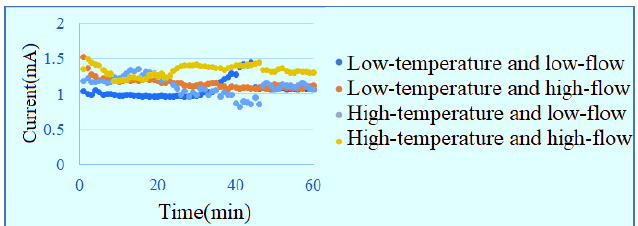
Figure 12. Current data at lower inlet of runner.